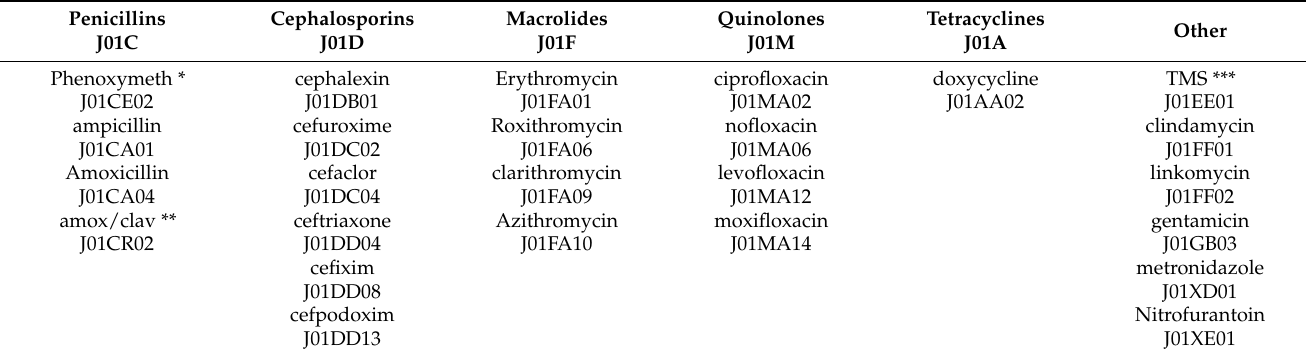
Table 1. Groups of antibiotics used in outpatients in RS during 2019 and